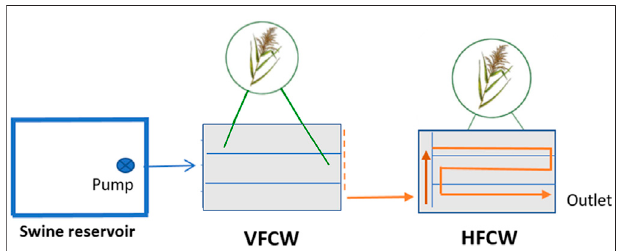
FIGURE 1 | Layout of the constructed wetland pilot plant treating swine